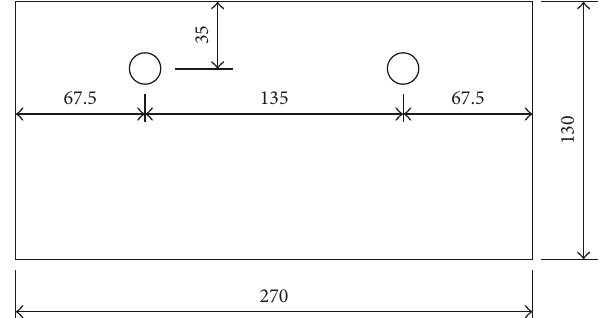
Figure 5: Cross-sectional geometry of the reinforced concrete beam (mm).